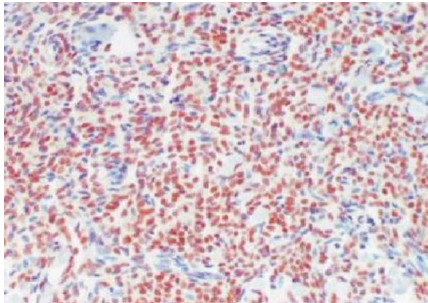
Figure 6: Immunohistochemistry picture showing estrogen receptor